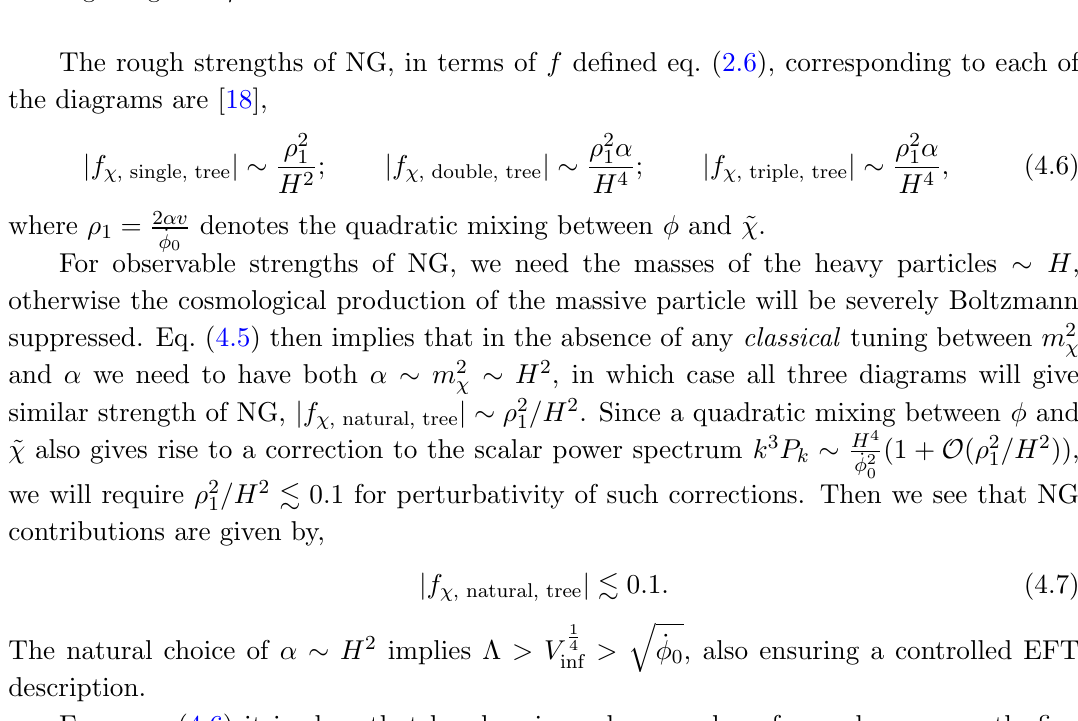
Figure 2 . Massive Higgs mediated (in red) tree level \in-in" contributions to the in(cid:13)aton (in black) three point function. Depending on the number of massive scalar propagators, these diagrams are labelled from left to right: (a) single exchange diagram, (b) double exchange diagram, (c) triple exchange diagram. (cid:17) denotes conformal time which ends at the end of